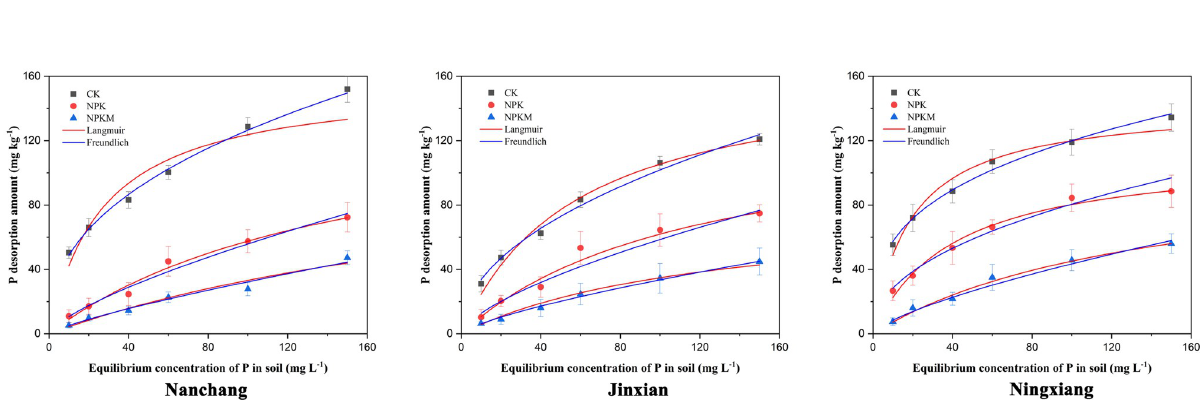
Fig 2. The desorption isotherms of P in red paddy soils under three different long-term experimental sites.